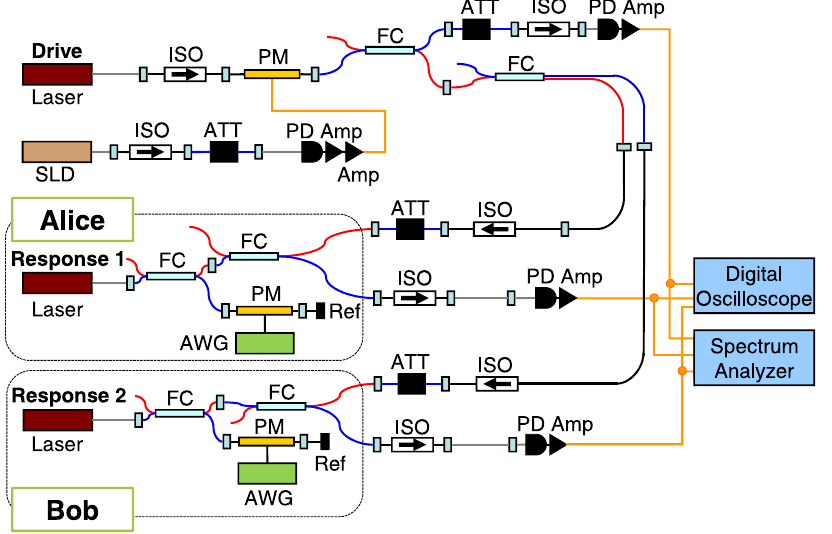
Figure 6. Experimental implementation of optical correlated random system based on optical fiber components for oblivious transfer. Amp: electronic amplifier, ATT: optical attenuator, AWG: arbitrary waveform generator, FC: fiber coupler, ISO: optical isolator, PD: photodetector, PM: phase modulator, Ref: fiber mirror reflector, SLD: super-luminescent